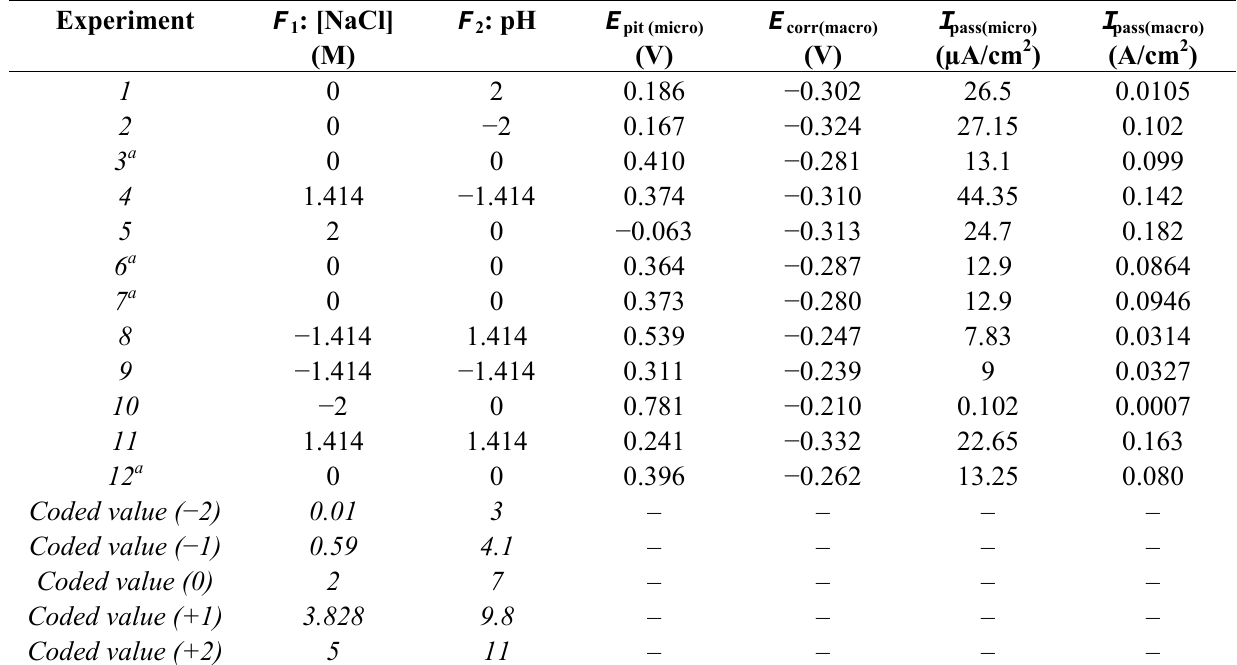
Table 1. Design matrix and relative E central composite design for two factors: NaCl concentration ( molar ) and pH. The letter “a” in the experiment column indicates the replicate measurements.